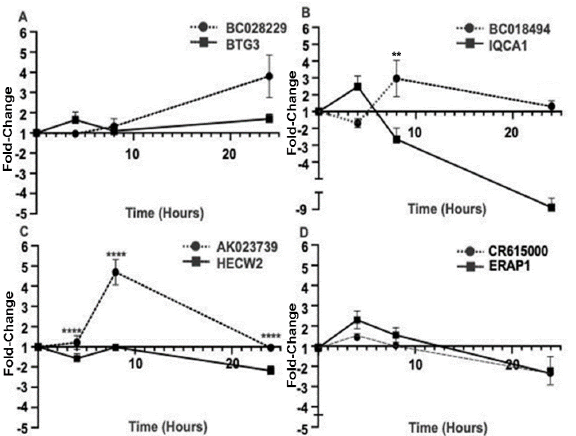
Figure 5. Sense-antisense coding/non-coding gene pairs demonstrate reciprocal expression patterns after repeated depolarizations. ( A ) Repeated KCl depolarizations in the Sh-SY5Y cells resulted in significantly different expressions of BC028229 and BTG3 at 24 hours ( p = 0.06, two-way ANOVA, n = 3, DF = 14), ( B ) BC018494 and IQCA1 at 24 h (** p < 0.01, two-way ANOVA, n = 3, DF = 14), and ( C ) AK023739 and HECW2 at four, eight, and 24 h (**** p < 0.0001, two-way ANOVA, n = 3, DF = 14). All results are displayed as fold changes in comparison to time matched control. ( D ) CR615000 and ERAP1 demonstrate similar patterns of expression with no significant changes between the two expression patterns. To confirm the potential regulation of protein-coding gene expression by its antisense expression lncRNA, we used siRNA to knock down the expression of these four antisense lncRNAs and measured the relative expression of both the lncRNA and its antisense protein-coding gene mRNA, and protein levels for BTG3 and HECW2 (based on antibody availabilities). While siRNA knock-down of BC018494 resulted in the greatest increase in mRNA, both BC028229 and AK023739 knockdown led to increases in the relative expression of BTG3 and HECW2 protein levels, respectively, on Western blots (Figure 6A – D). While further validation studies are required, this suggests that these two lncRNAs may inhibit the ex- pression of their antisense protein-coding genes in neuronal-like cells. This result is con- sistent with our previous finding that the lncRNA BDNF-AS1 is a negative regulator of the BDNF gene in epilepsy [12]. Unfortunately, antibodies were not available at the time of experimentation for the other two protein-coding genes. However, similar results were observed with siRNA knockdown of BC018494 (Figure 6E), and CR615000 (Figure 6F).